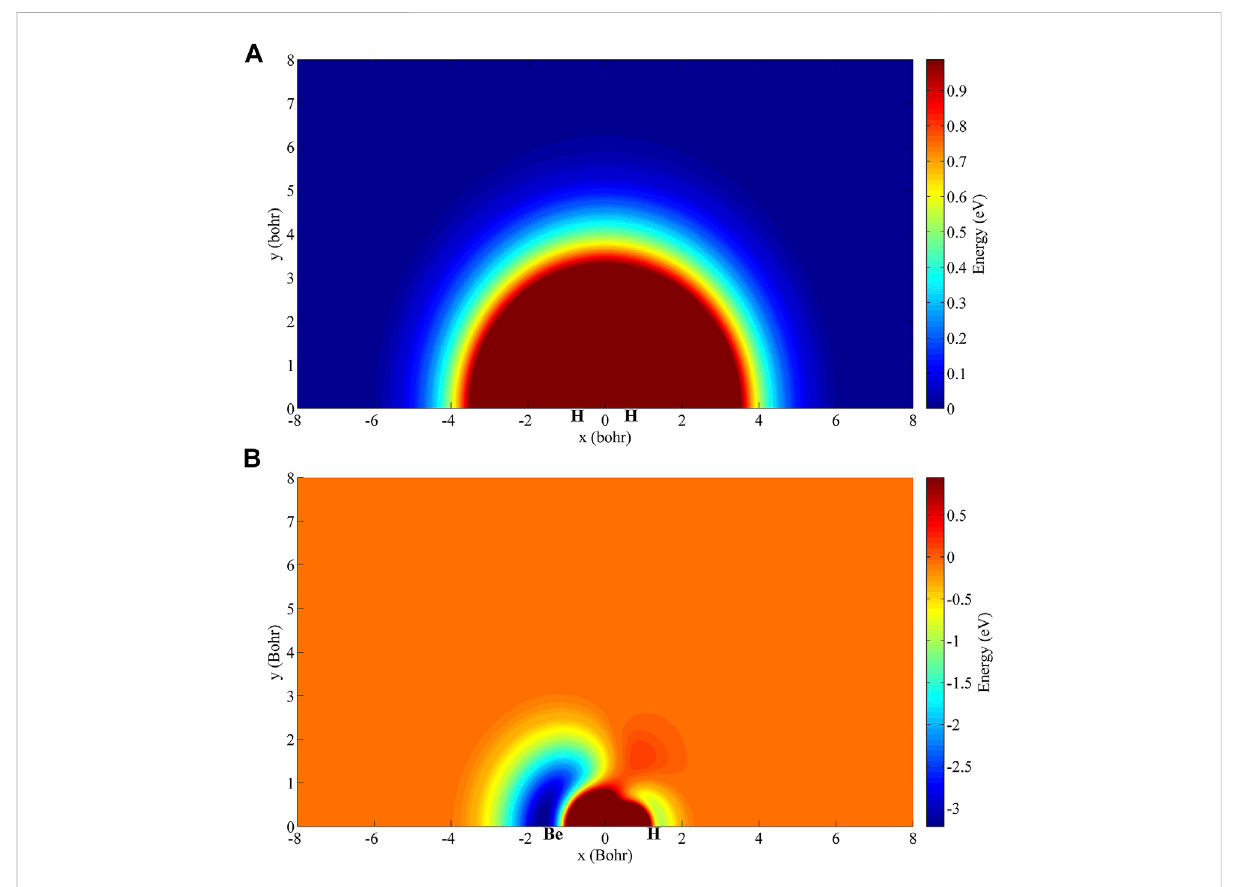
FIGURE 6 (A) Contour plot of the ground-state BeH 2 PES when the Be atom moves around the H 2 molecule with the fi xed bond length at 1.401 a 0 (B) Contour plot of the ground-state BeH 2 PES when a H atom moves around the BeH molecule with the fi xed bond length at 2.544 a 0